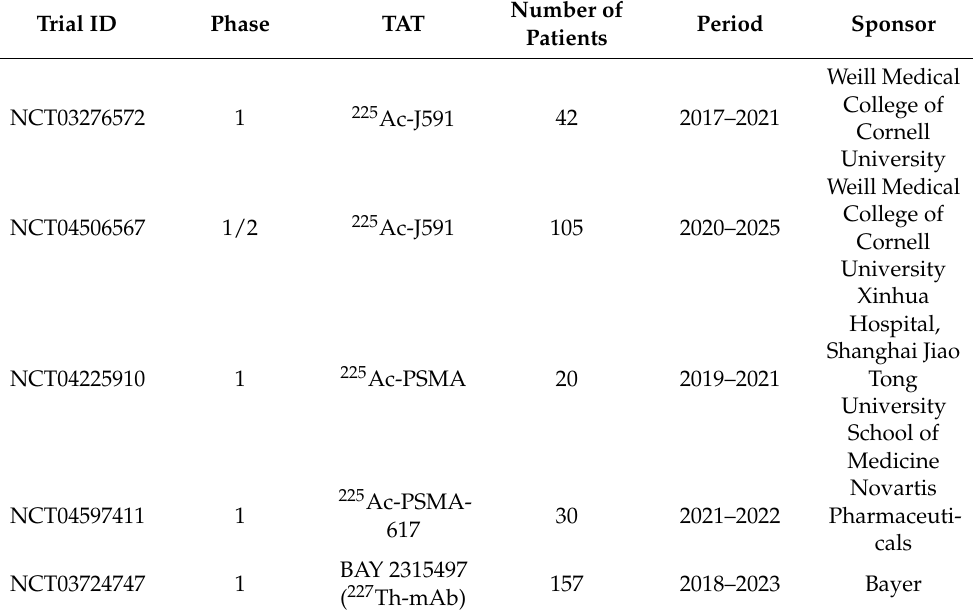
Table 6. Ongoing clinical trials with targeted α therapies (TAT) targeting PSMA in metastatic castration-resistant prostate cancer (mCRPC) patients registered in https://clinicaltrials.gov/ (ac- cessed on 14 January